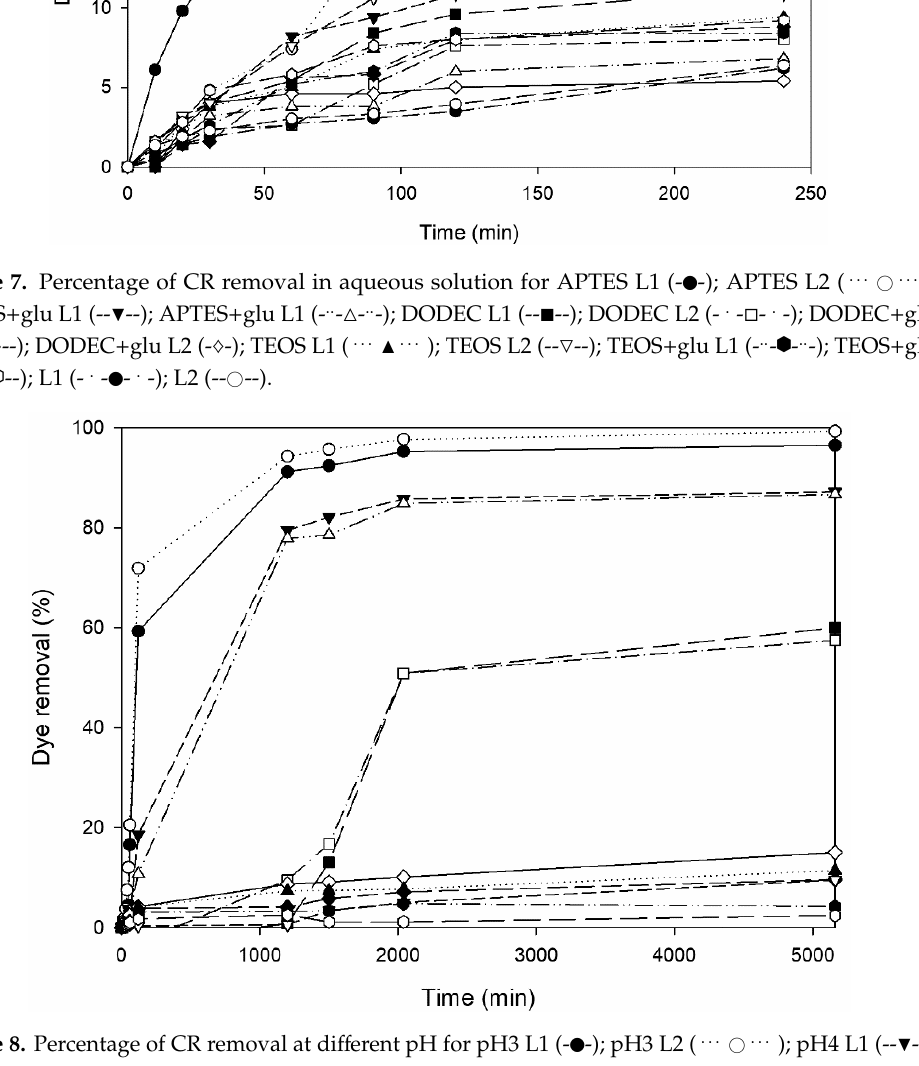
Figure 8. Percentage of CR removal at different pH for pH3 L1 (-●-); pH3 L2 ( … ○ … ); pH4 L1 (-- ▼ --); pH4 L2 (- .. - △ - .. -); pH5 L1 (-- ■ --); pH5 L2 (- . -□- . -); pH6 L1 (-- ♦ --); pH6 L2 (- ♢ -); pH7 L1 ( … ▲ … ); pH7 L2 (-- ▽ --); pH8 L1 (- .. - ⬢ - .. -); pH8 L2 (-- ⬡ Table 1. Langmuir Isotherm data for the two types of substrates.